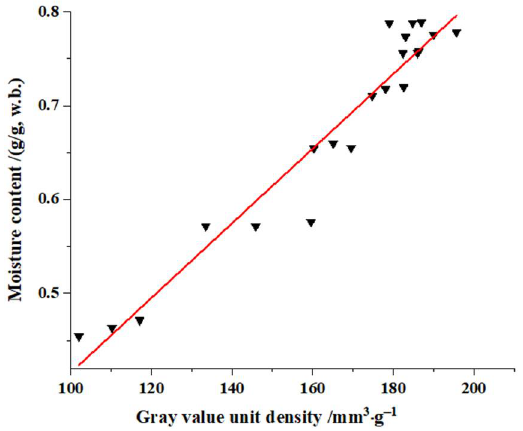
Figure 9. Fitting curve between the image gray value of the LF-NMR and the moisture content.